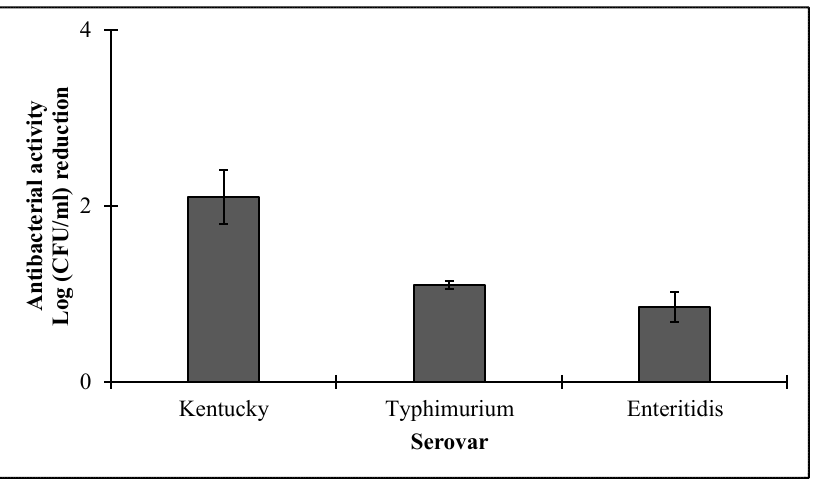
Figure 7. Serovar spectrum of Cecropin A/HEWL combination. LB exponentially grown Salmonella enterica serovars Kentucky, Typhimurium and Enteritidis were pelted, diluted to 10 6 CFU/mL and resuspended in 10 mM potassium phosphate buffer. The prepared culture was then subjected to a combination of 500 µg/mL HEWL mixed with 0.5 µg/mL of cecropin A. Controls were performed using 10 mM potassium phosphate buffer instead of protein. Each value represents the mean ± standard deviation from three independent replicates.